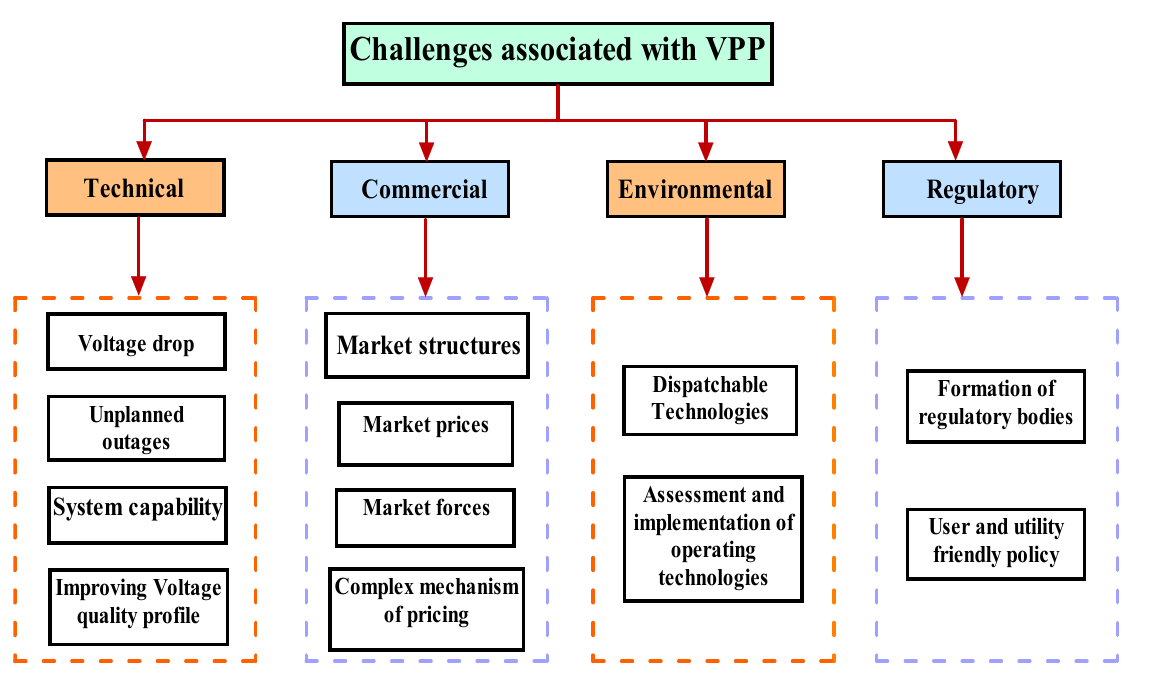
Figure 2. Different aspects of VPP.